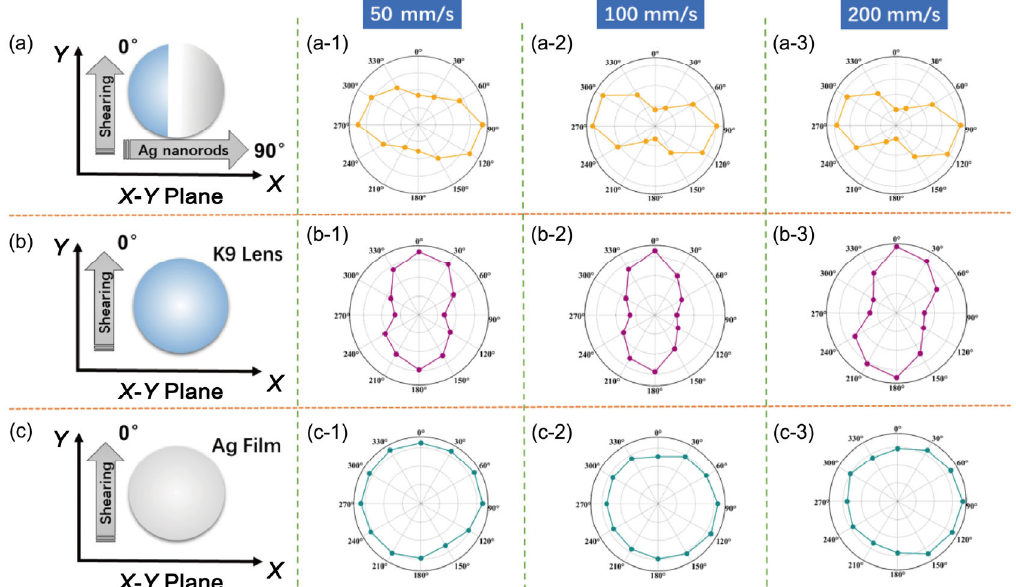
Fig. 11 Raman relative intensity graphs of 6CB on different substrates under shearing. The shear-flow speed is marked at the top of each pair. (a-1) − (a-3) performed on Ag nanorod film bases, (b-1) − (b-3) performed on K9 plano-convex lens, (c-1) − (c-3) performed on flat Ag film bases. Reproduced with permission from Ref. [108]. © The author(s),